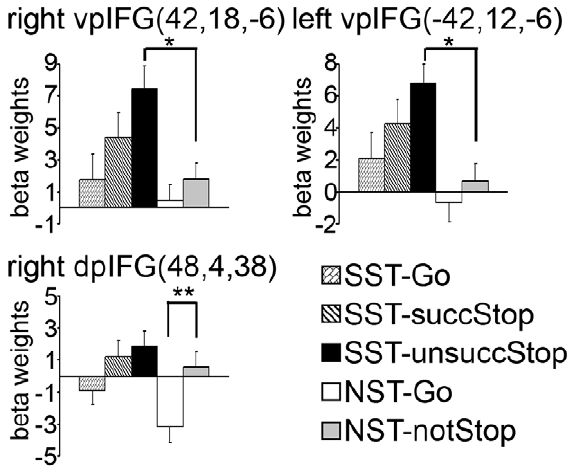
Figure 3. Activation patterns of pre-defined IFG ROIs during response control across trial types. Three ROIs were defined using coordinates reported in previous neuroimaging studies of relevant topics, including right vpIFG, left vpIFG and right dpIFG/IFJ. In each bar chart, the bars from left to right show the average beta weights in correspondence to the various trial types: SST-Go, SST-succStop, SST- unsuccStop, NST-Go, and NST-notStop. Error bars show the standard error. The coordinates (x, y, z) are in mm. *, p , 0.05; **, p , 0.01, corrected for multiple comparisons. All ROIs showed significantly stronger activity on stop trials (SST-allStop) in comparison to go trials (not marked). Abbreviations: vpIFG: ventral-posterior IFG; dpIFG: dorsal- posterior